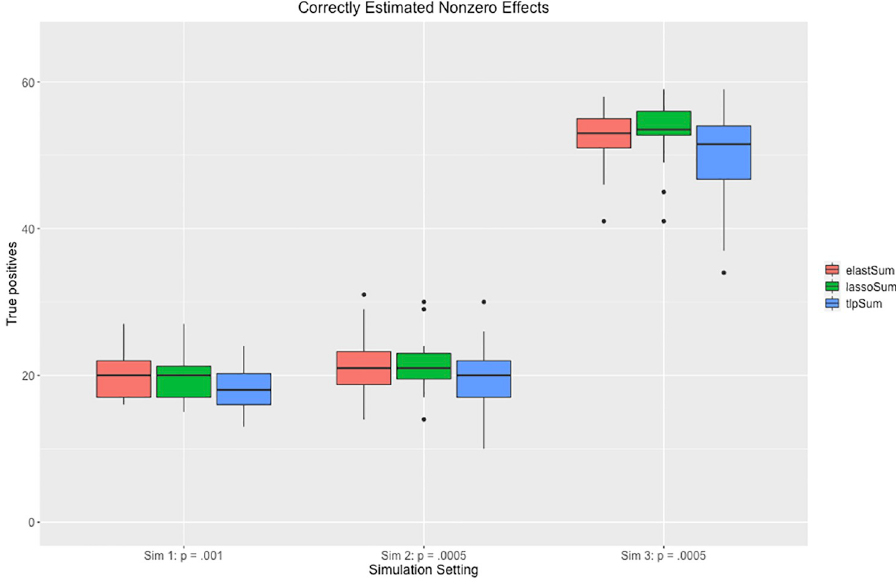
Fig 7. Number of true positives for the three penalized regression methods in the three sparse simulation